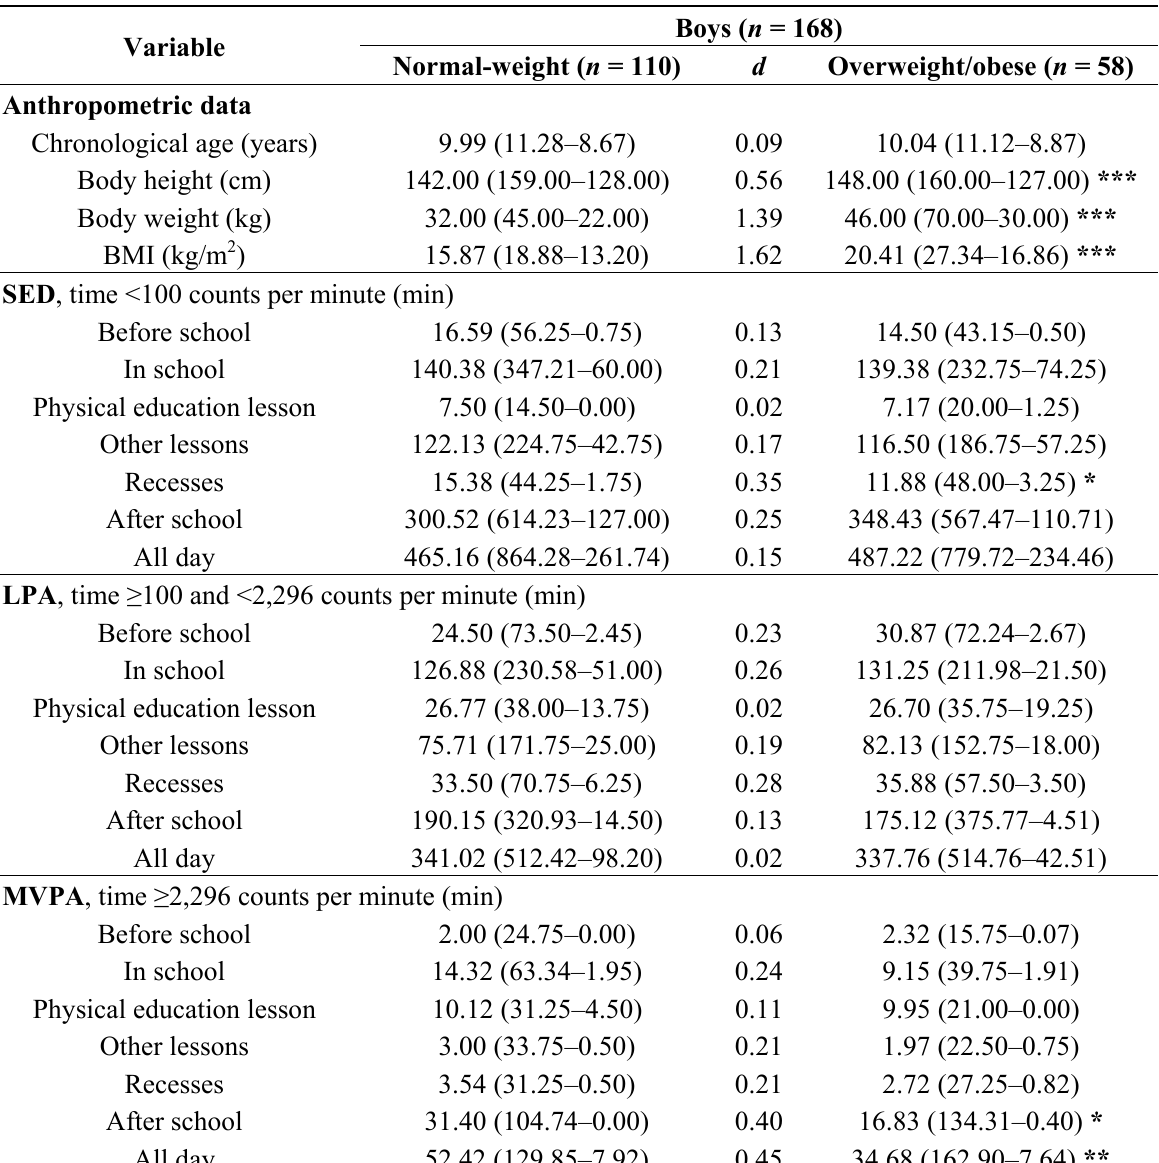
Table 2. Anthropometric characteristics and duration of sedentary time and physical activity levels during 2-day monitoring (median (full ranges)) in overweight/obese and normal-weight